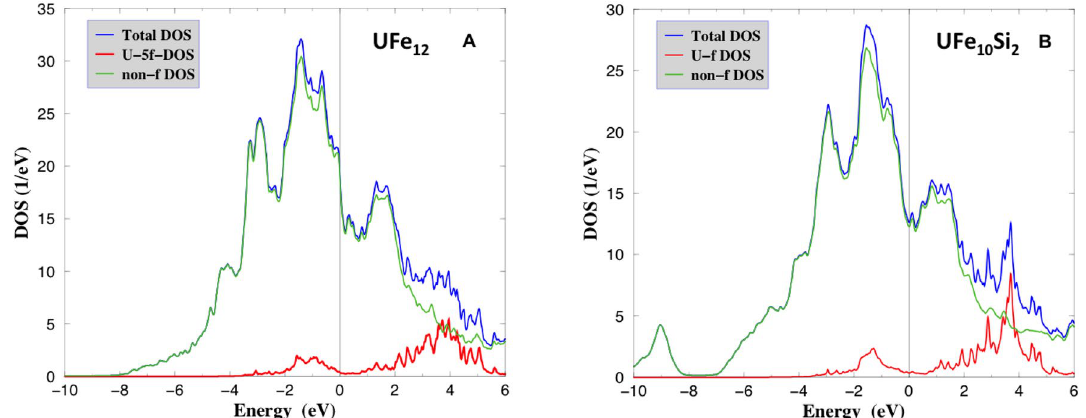
Figure 3. ( A ) The total DOS, orbital-resolved U-5f and a sum of all non-f DOS for UFe 12 . ( B ) The total DOS, orbital-resolved U-5f and a sum of all non-f DOS for UFe 10 Si 2